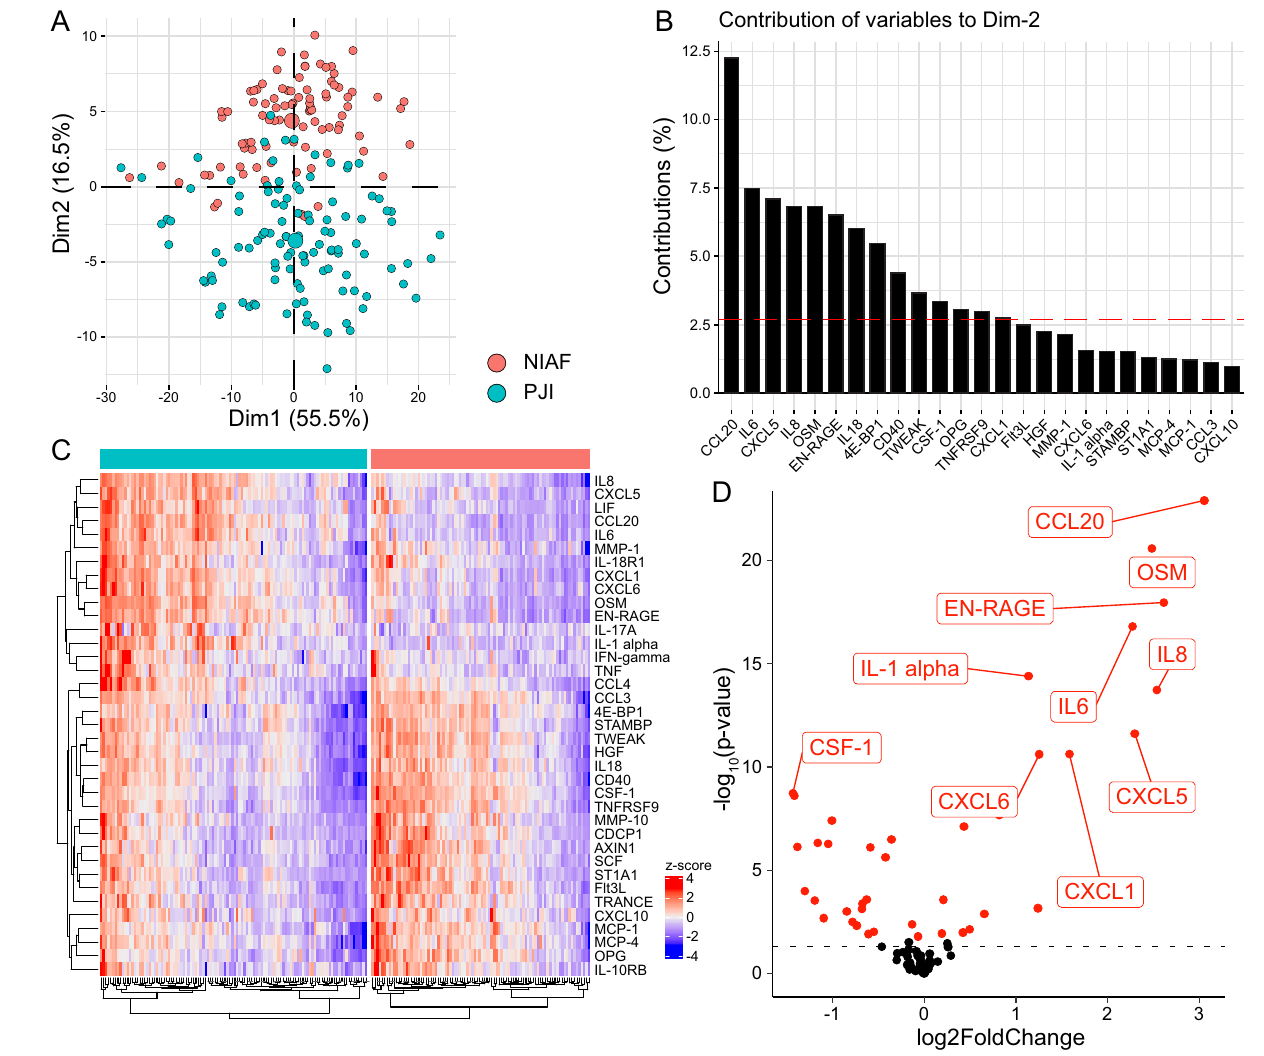
Figure 1. Proteomic profiling of sonicate fluids from periprosthetic joint infection (PJI) and non-infectious arthroplasty failure (NIAF) using the Olink Proteomics - Inflammation Panel. ( A ) Principal component analysis (PCA) showing grouping of NIAF and PJI based on Dim1 and Dim2. Larger points indicate geometric means of the sample population. ( B ) Contribution plot showing protein targets with the most contribution to separation on the PCA Dim2. ( C ) Heatmap analysis of protein expression z-scores in NIAF and PJI samples, with differentially expressed protein targets clustered and shown. ( D ) Volcano plot of NIAF versus PJI samples, with significantly and non-significantly differentially expressed protein targets shown in red and black, respectively. The top 10 differentially expressed proteins are labeled. The horizontal dashed line in D designates a P -value = 0.05. Statistical significance was determined via Welch’s 2-sample t-test, with Benjamini–Hochberg multiple comparison adjustment. Data depicted are for NIAF (n = 90) and PJI (n = 110) sonicate fluid